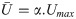
Principle of PWM.The voltage U¯=α.Umax is obtained by interrupting the tension U
max every T period during αT.